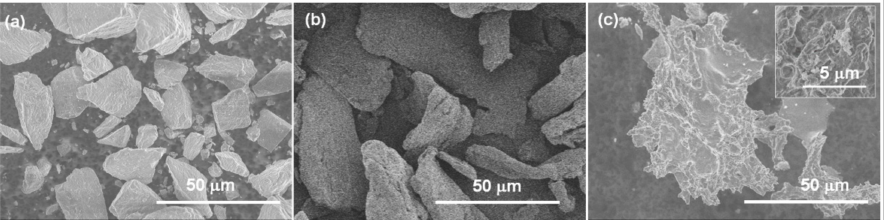
Figure 1. SEM images of Laponite ( a ), cellulose ( b ) and cellulose/Laponite composite ( c ). The inset of ( c ) is the cellulose/Laponite particles observed at a larger magnitude.